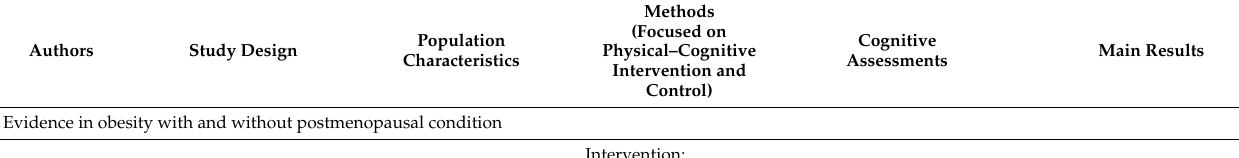
Table 2. Studies investigating the effects of physical–cognitive intervention on cognitive function and health-related